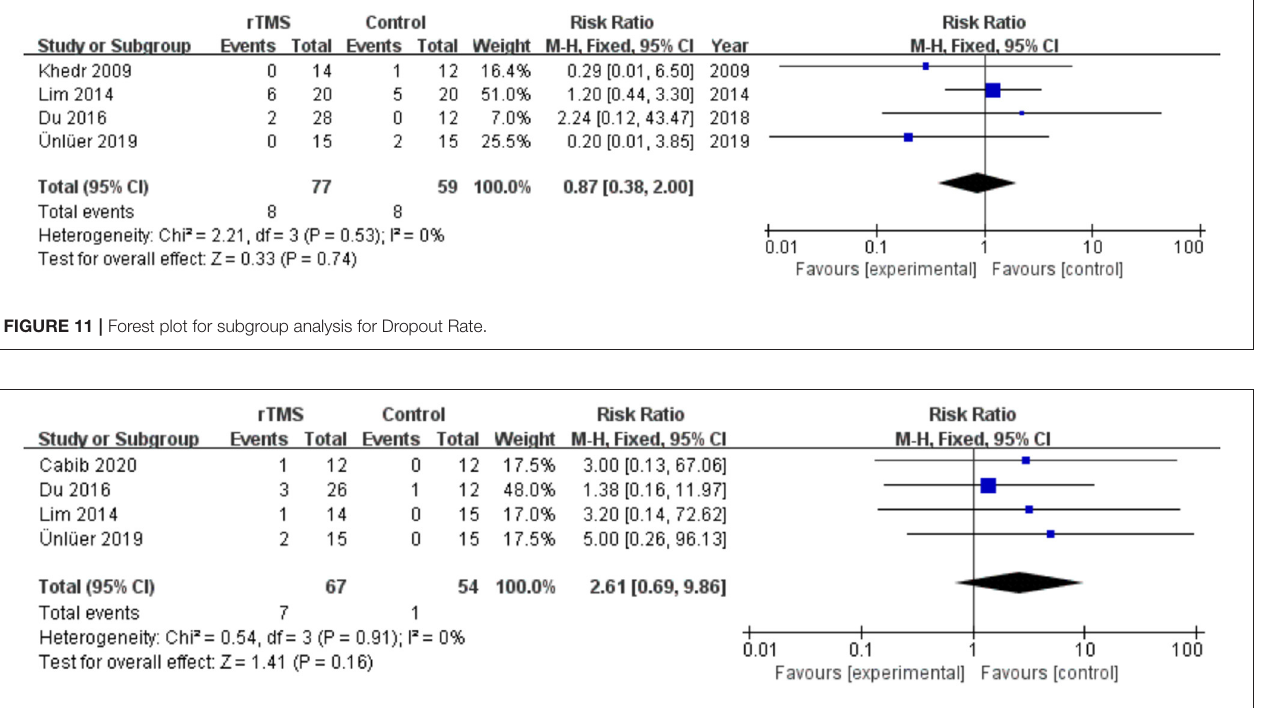
FIGURE 12 | Forest plot for subgroup analysis for Adverse